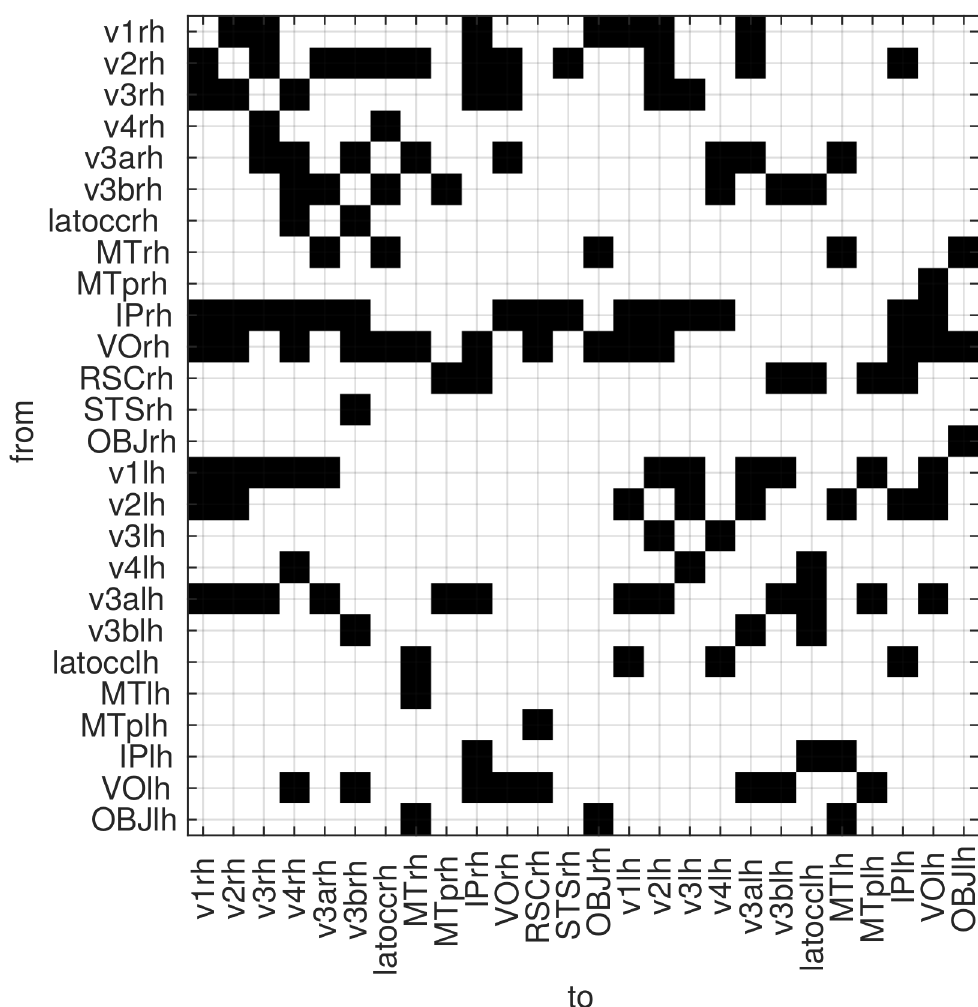
Fig 8. The causal configuration matrix computed on the empirical fMRI data, the black squares indicate a causal interaction from the rows to the